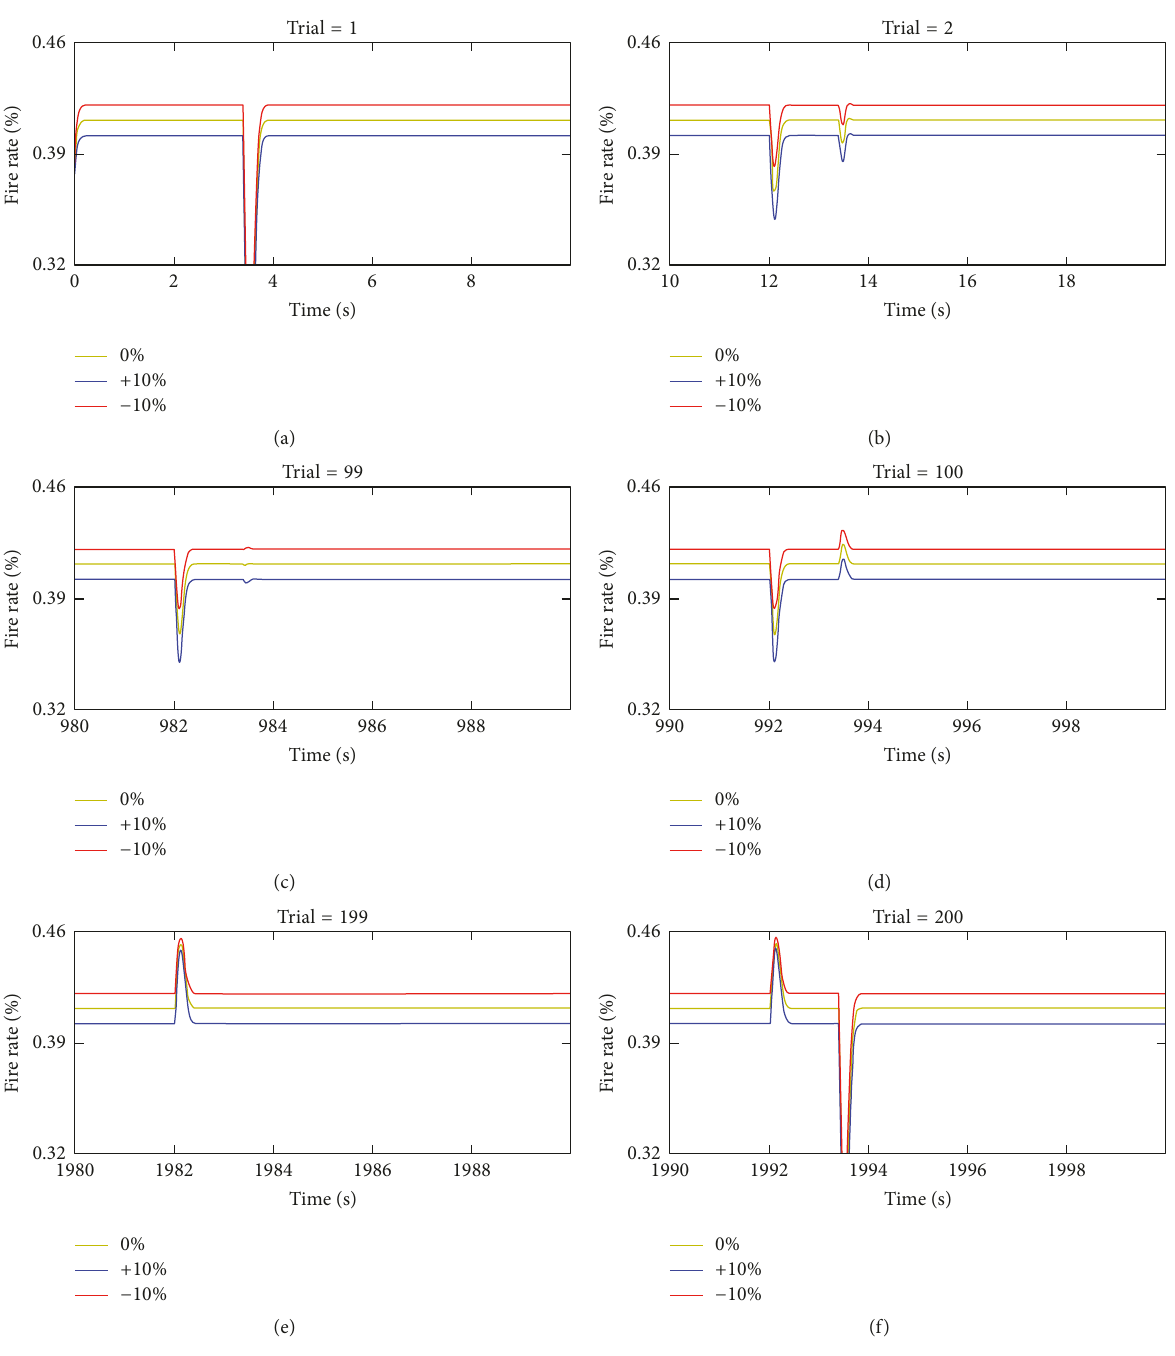
Figure 10: The phasic activity of LHb neurons given different weights of synapses from VP to GPb. Yellow lines indicate the activity of LHb neurons when 𝑊 equals 1.00 and 𝐷 equals 0.19431, blue lines indicate the activity when 𝑊 equals 1.10 and 𝐷 equals 0.20307, and red lines VPG VPG indicate the activity when 𝑊 equals 0.90 and 𝐷 equals 0.18608. (a) Trial 1: phasic dip activity responds to unconditional reward. (b) Trial 2: VPG the phasic activity shifts to the cue. (c) Trial 99: the phasic activity upon the cue and baseline activity upon the reward. (d) Trial 100: the peak activity upon reward omission. (e) Trial 199: the peak activity upon nonrewarding cue. (f) Trial 200: the dip activity upon unexpected